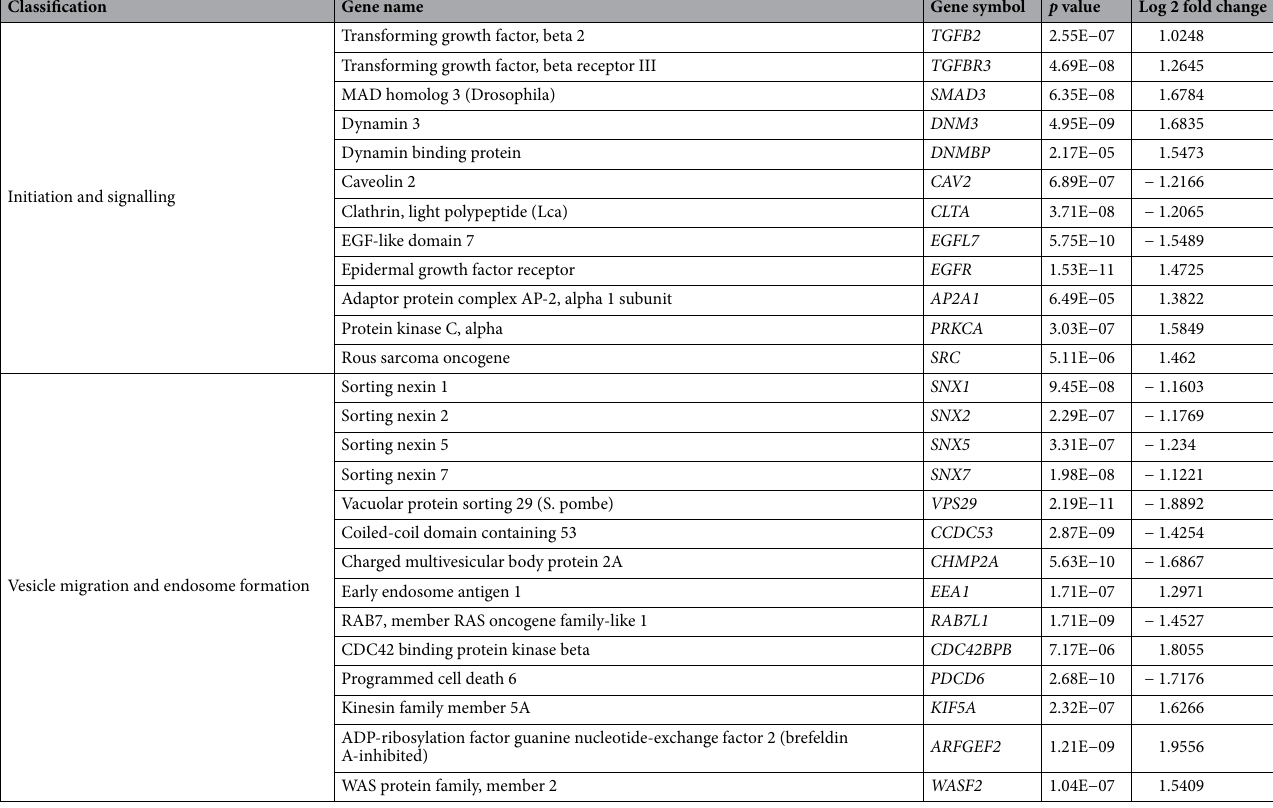
Table 6. List of genes involved in endocytosis pathway that are differentially expressed in the pup brain, in response to maternal H. bakeri infection. Differential regulation as reported by Haque et al. 12